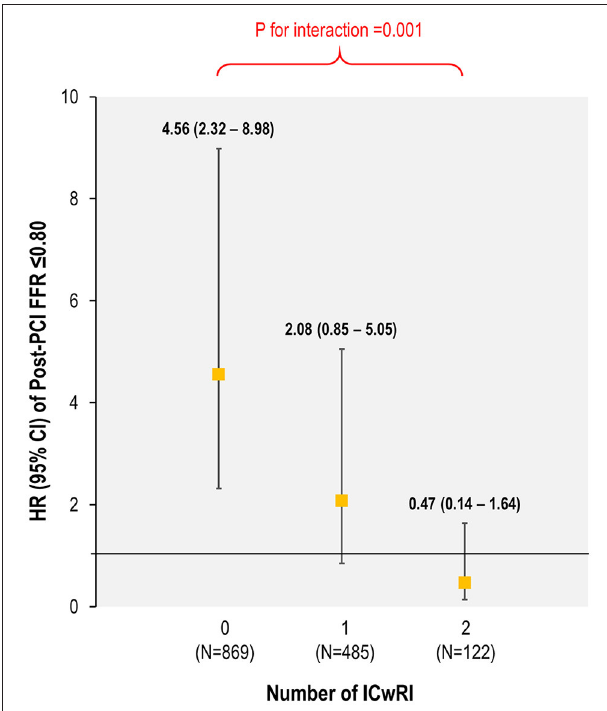
FIGURE 4 | Differential prognostic implications of residual ischemia according to the number of ICwRI. The hazard for TVF at 2 years of residual ischemia according to the number of ICwRI is shown. The ICwRI definitions are described in Figure 3 . CI, confidence interval; FFR, fractional flow reserve; HR, hazard ratio; ICwRI, interaction characteristics with residual ischemia; PCI, percutaneous coronary intervention.